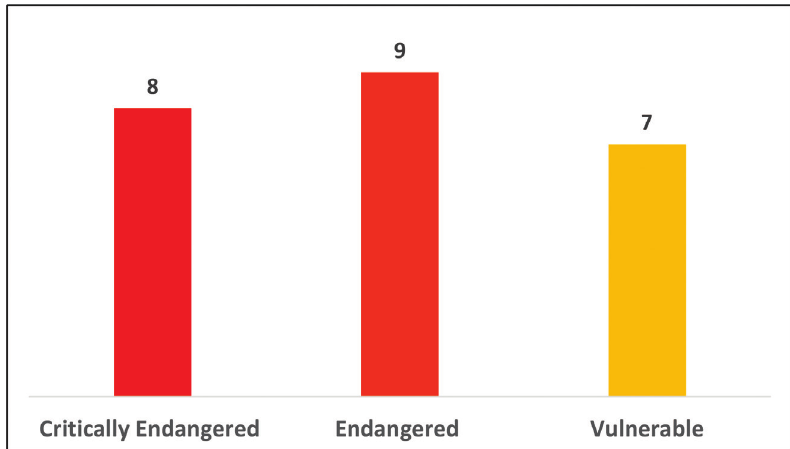
Figure 1. Conservation status of freshwater turtles and tortoises in Vietnam (IUCN Red List